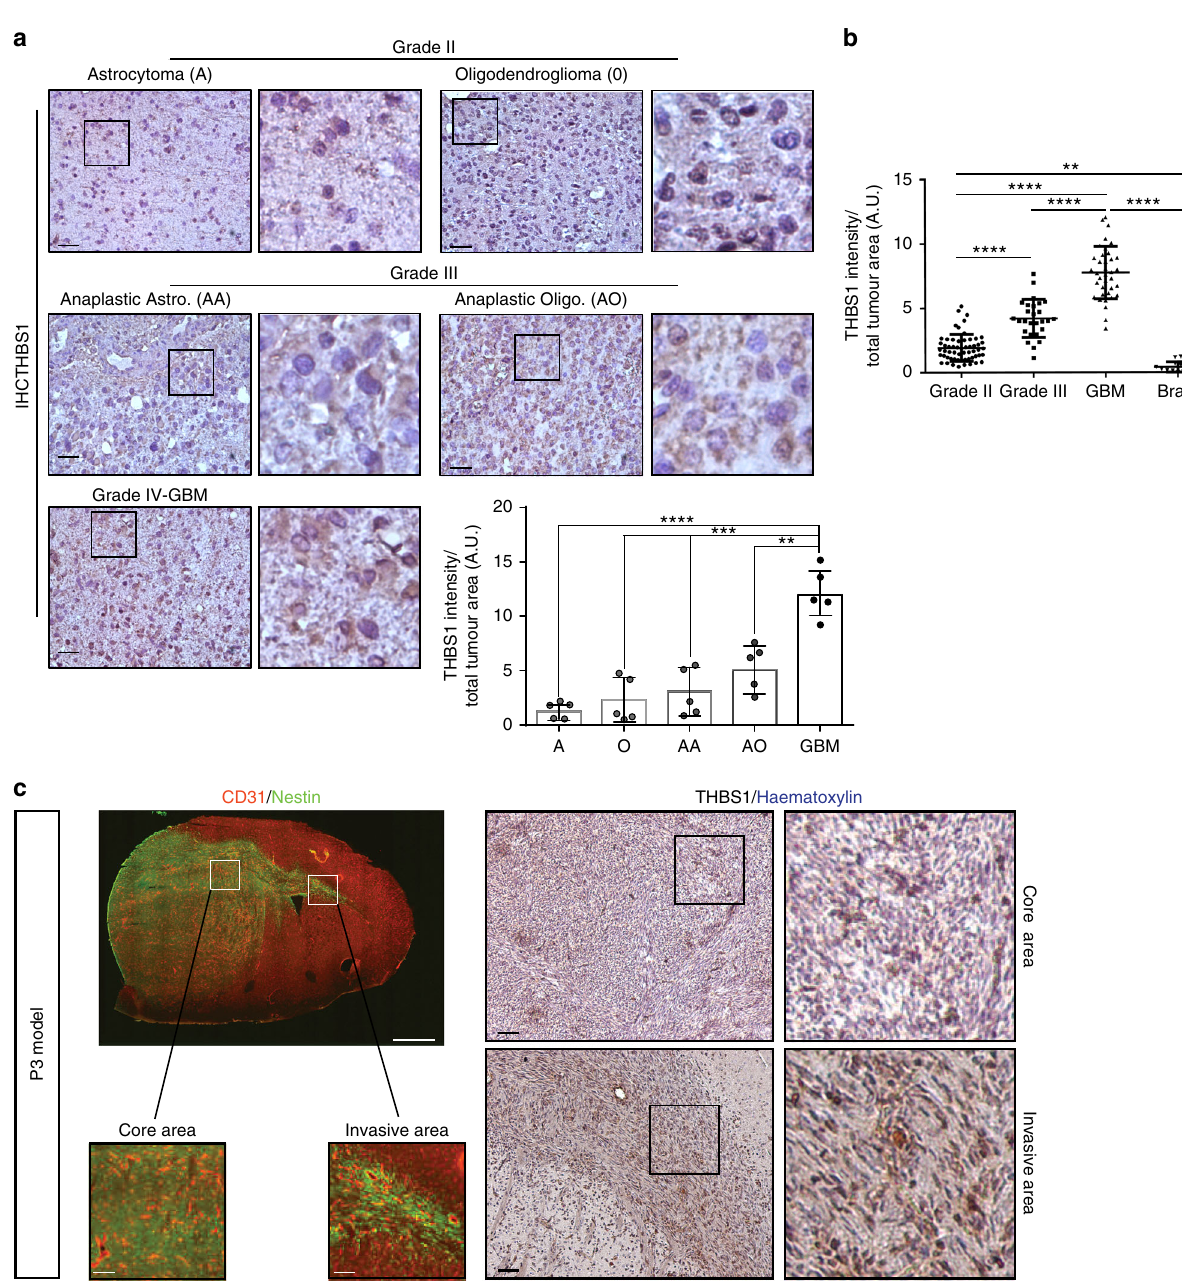
Fig. 1 THBS1 is a marker of high-grade glioma. a Immunohistochemistry (IHC) of THBS1 in patient samples from grade II astrocytomas and oligodendrogliomas (upper panels), grade III anaplastic astrocytomas and anaplastic oligodendrogliomas (middle panels) and grade IV glioblastomas (lower panels). Magni fi cation of tumour areas is shown in each panel on the right hand side. Scale: 50 µ m. Quanti fi cation of THBS1 staining by IHC pro fi ler from Fiji software. A, astrocytomas ( n = 5); O, oligodendrogliomas ( n = 5); AA, anaplastic astrocytomas ( n = 5); AO, anaplastic oligodendrogliomas ( n = 5); and GBM, glioblastomas ( n = 5). The graph represents the results as means ± s.d. ** P < 0.01; *** P < 0.001; **** P < 0.0001; ns not signi fi cant (ANOVA). b Quanti fi cation of THBS1 staining by using tissue microarrays. 121 patients were analysed using TMA (Biomax), and IHC with anti-THBS1 antibodies. 57 were of grade II, 27 of grade III and 37 of GBM – grade IV. The graph represents the results as means ± s.d. ** P < 0.01; **** P < 0.0001 (ANOVA). c Left panels: immuno fl uorescence stainings of CD31 (red) and Nestin (green) of a P3 tumour section. Images below represent core and invasive areas. Scales: 500 µ m (upper panel) and 20 µ m (lower panels). Right panels: IHC for THBS1 in samples representing core and invasive areas in P3 tumours, counterstained with haematoxylin. THBS1 is expressed in invasive areas of P3 tumours. Scale: 50 µ 1.67 ± 0.07-fold increase of THBS1 protein expression) (Fig. 2a). BB, or IL-1 β stimulation (Supplementary Fig. 4C). Immunostain- To corroborate our observations, we stimulated two other ing revealed that THBS1 appeared as small aligned dots along cell patient-derived cell lines (BL9 and BL13) with recombinant protrusions that were further increased under TGF β 1 stimulation TGF β 1, and observed a time-dependent increase in THBS1 (Supplementary Fig. 4D). THBS1 expression and secretion were expression (Supplementary Fig. 4B). THBS1 expression was only measured by ELISA in both cell extracts and in the extracellular increased after TGF β 1 stimulation, not after TGF β 2, EGF, PDGF- environment (free-THBS1) (Fig. 2b). Induction by TGF β 1 was